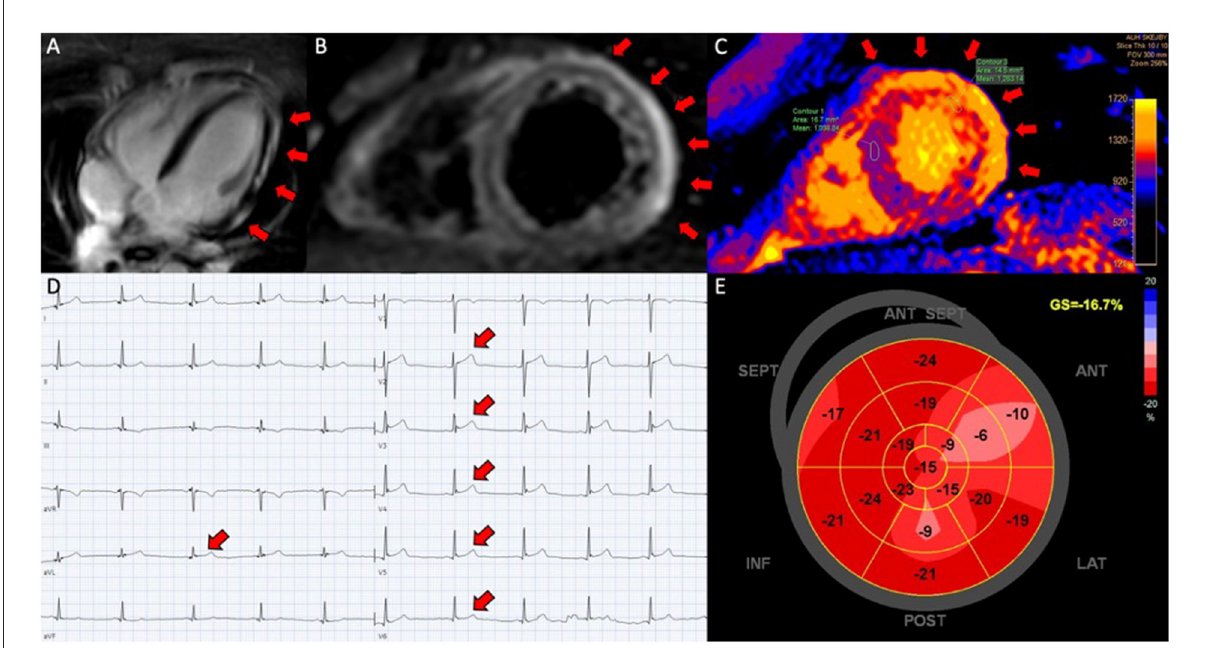
FIGURE1 Perimyocarditis in a patient (case 3). (A) Late gadolinium enhancement in the epicardium at the lateral segments in 4-chamber view; (B) CMR, short axis T2-weigthed image showing hyper-intensive signal in the epicardium along the lateral segments indicative of oedema; (C) T1-map in short axis showing increased T1 values up to 1,191ms at the lateral segments reflecting myocardial injury; (D) electrocardiogram showing ST-elevations in lead V2-V6 and aVL; (E) 17-segment plot of global longitudinal strain on echocardiography with decreased values